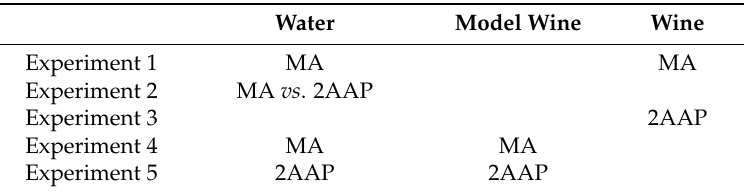
Table 1. Overview of five experiments, summarizing the relative comparisons of which odorants were tested, as well as the matrix they were tested in, for each experiment. Water Model